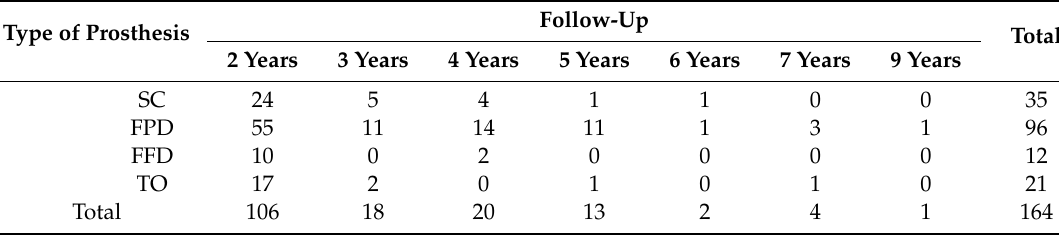
Table 3. Frequency of prosthesis type and respective follow-up time. SC: Single Crown; FPD: Fixed partial denture; FFD: Fixed full denture; TO: Toronto bridge.